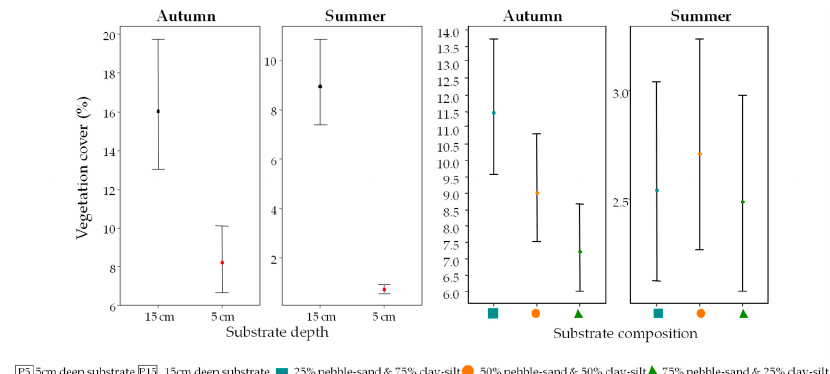
Figure 6. Effect of season, substrate composition and substrate depth interactions on vegetation cover on the roof of Avignon IUT (Southeastern France) in summer and autumn 2016. Values are means ± standard errors.